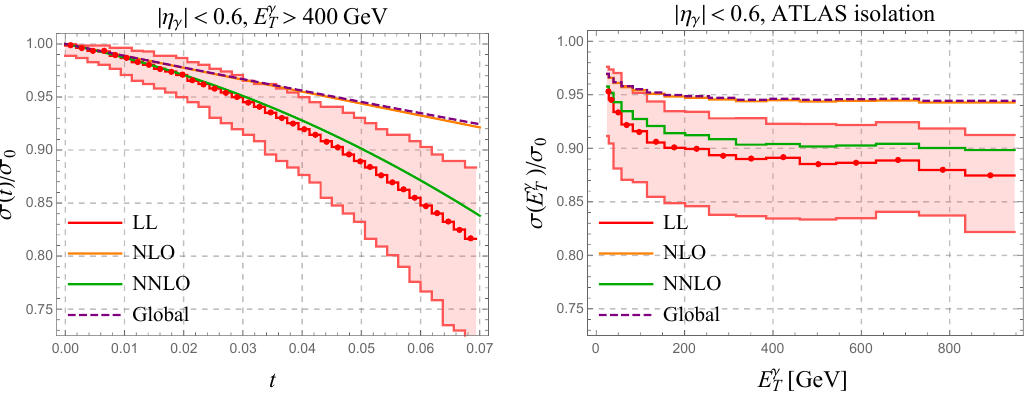
Figure 10 . Ratio of the pp ! (cid:13) + X cross section with isolation to the inclusive one. Left: ratio as a function of t (or equivalently (cid:15) (cid:13) ) for E (cid:13) > 400 GeV. Right: ratio for the ATLAS isolation T criterion (4.14) as a function of E (cid:13) . In both plots we show the resummed result as well as its NLO T and NNLO expansions obtained using the approximation (4.11). The red uncertainty bands are obtained by scale variations, see